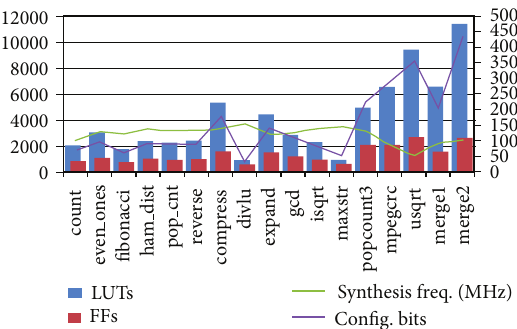
F 15: FPGA resources, synthesis frequency, and required con�guration bits for each RPU with a PLB interface (LUTs and FFs shown on the le